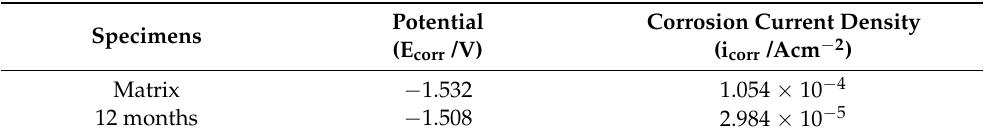
Figure 12. The polarization curves of AZ31 magnesium alloy matrix and specimen after exposure for 12 months in marine environment of ocean voyage. Table 6. The corrosion potentials (E corr ) and corrosion current density (i corr ) obtained from anodic polarization curves of AZ31 magnesium alloy.